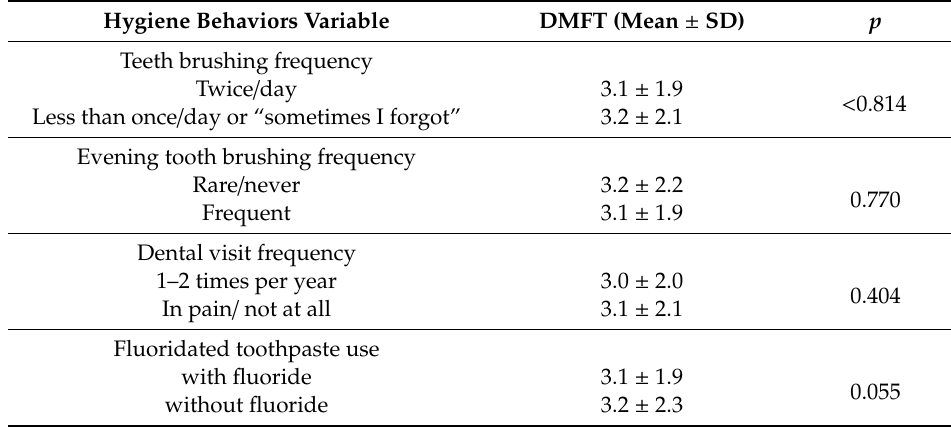
Table 2. Hygiene practices and decayed, missing, and filled teeth (DMFT) index.